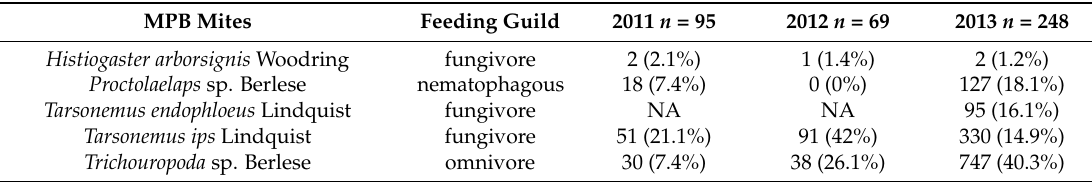
Table 1. Total number of phoretic mites on mountain pine beetles (MPB) attacking P. ponderosa , P. contorta , from 2011 to 2013 and P. flexilis in 2013 ( n = MPBs sampled). Samples from beetles arriving at P. flexilis were only obtained in 2013. NA— T. endophloeus was only sampled in 2013. Percent of MPBs carrying mites shown in